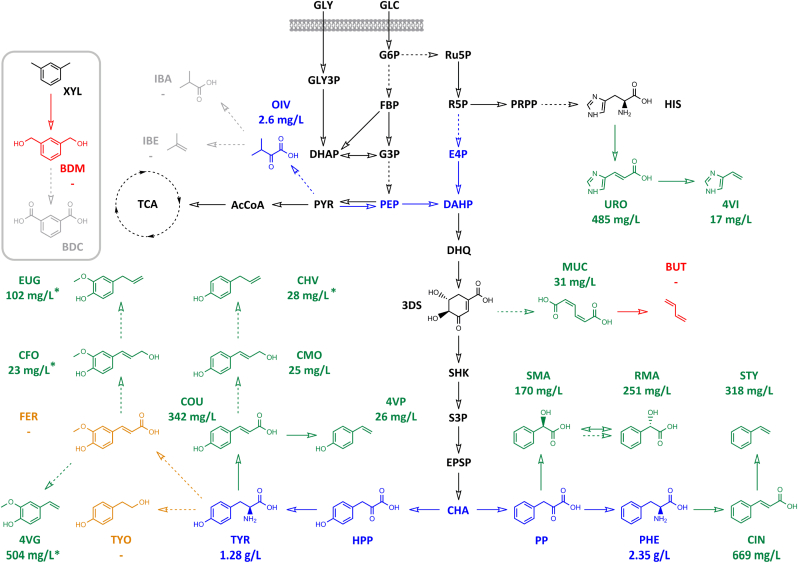
Biosynthetic routes to material monomer targets. Target compounds and primary metabolite precursors are represented as skeletal formulae, whilst other E. coli primary metabolites are shown as abbreviations. Continuous arrows show single enzyme conversion steps, and dashed arrows indicate multiple enzyme steps. Engineering of the E. coli host to boost production of primary metabolite precursors is highlighted in blue. Targets successfully produced in vivo are highlighted in green, with growth media titers indicated (asterisks show titers from feeding of phenylacrylic acid precursors). Orange targets were produced enzymatically in vitro. Where no active enzyme candidates were identified the targets are red, whilst enzyme steps to gray targets could not be verified within the benchmarking timeframe. Abbreviations used: 3-dehydroshikimate (3DS); 4-vinylguaiacol (4VG); 4-vinylimidazole (4VI); 4-vinylphenol (4VP); acetyl-coenzyme A (AcCoA); benzene dicarboxylate (BDC); benzene dimethanol (BDM); butadiene (BUT); coniferyl alcohol (CFO); chorismate (CHA); chavicol (CHV); cinnamic acid (CIN); coumaryl alcohol (CMO); coumaric acid (COU); 3-deoxy-D-arabinoheptulosonate-7-phosphate (DAHP); dihydroxyacetone phosphate (DHAP); 3-dehydroquinate (DHQ); erythrose-4-phosphate (E4P); 5-enolpyruvylshikimate-3-phosphate (EPSP); eugenol (EUG); fructose-1,6-bisphosphate (FBP); ferulic acid (FER); glucose-3-phosphate (G3P); glucose-6-phosphate (G6P); glucose (GLC); glycerol (GLY); glycerol-3-phosphate (GLY3P); histidine (HIS); 4-hydroxyphenylpyruvate (HPP); isobutyric acid (IBA); isobutene (IBE); muconic acid (MUC); 2-oxoisovaleric acid (OIV); phosphoenolpyruvate (PEP); phenylalanine (PHE); phenylpyruvate (PP); phosphoribosyl-pyrophosphate (PRPP); pyruvate (PYR); ribose-5-phosphate (R5P); (R)-mandelic acid (RMA); ribulose-5-phosphate (Ru5P); shikimate-3-phosphate (S3P); shikimate (SHK); (S)-mandelic acid (SMA); styrene (STY); tricarboxylic acid cycle (TCA); tyrosol (TYO); tyrosine (TYR); urocanic acid (URO); xylene (XYL). (For interpretation of the references to color in this figure legend, the reader is referred to the Web version of this article.)